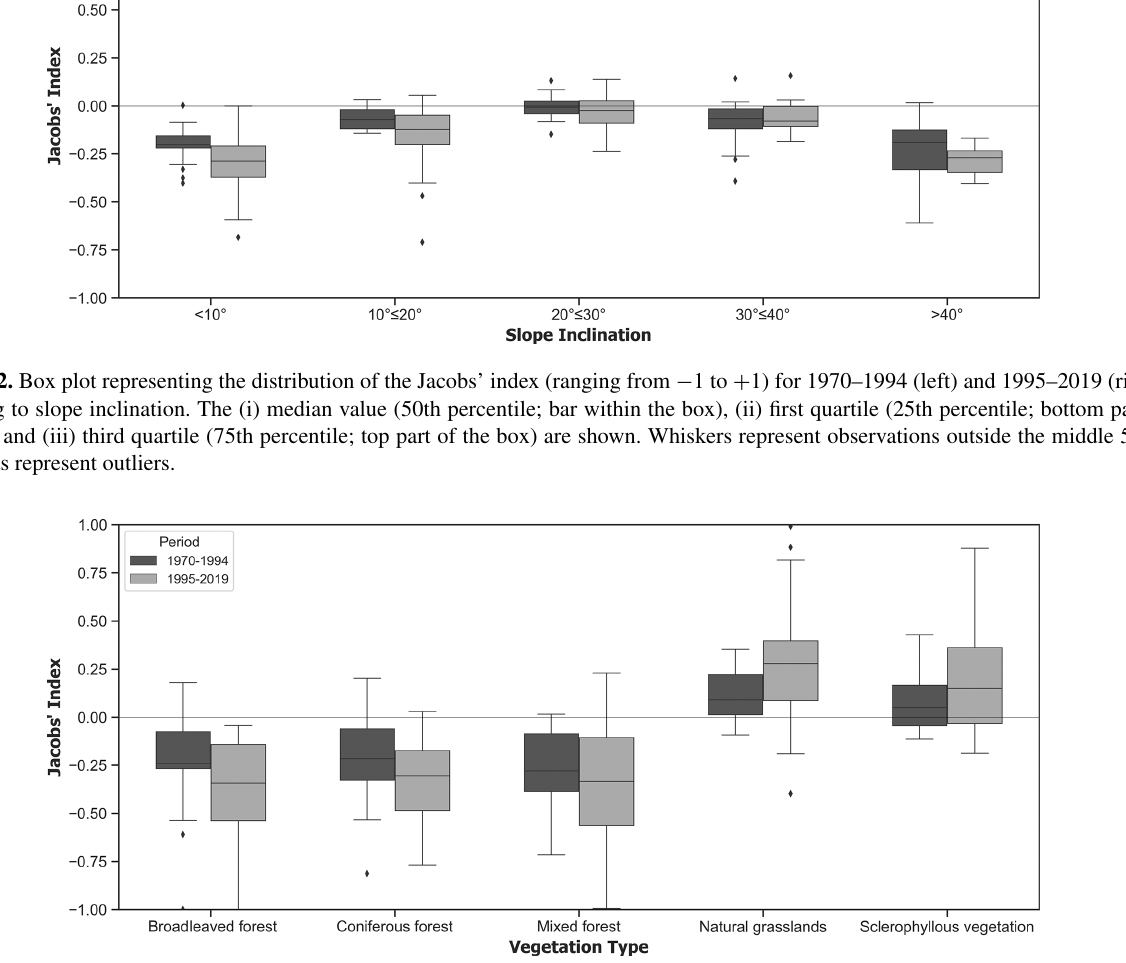
Figure 13. Box plot representing the distribution of the Jacobs’ index (ranging from − 1 to + 1) for 1970–1994 (left) and 1995–2019 (right) according to vegetation type. The (i) median value (50th percentile; bar within the box), (ii) first quartile (25th percentile; bottom part of the box), and (iii) third quartile (75th percentile; top part of the box) are shown. Whiskers represent observations outside the middle 50%, and points represent